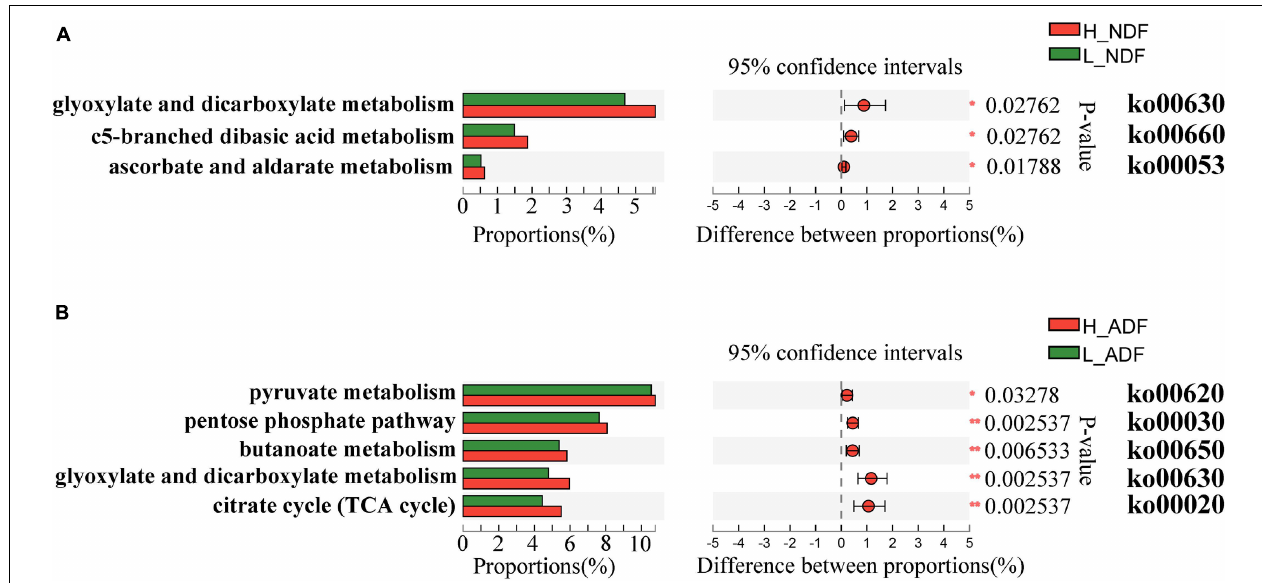
FIGURE 10 | The KEGG on pathway level 3 under the level 2 carbohydrate metabolism functional differences were analyzed between H_NDF group and L_NDF group (A) and between H_ADF group and L_ADF group (B) by Wilcoxon rank-sum test. An asterisk ( P < 0.05) or double asterisk ( P < 0.01) indicate significantly